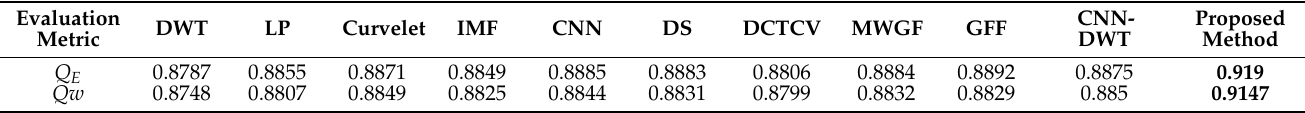
Table 26. The outcomes for the lab image and comparisons with existing techniques in the literature ([25]).